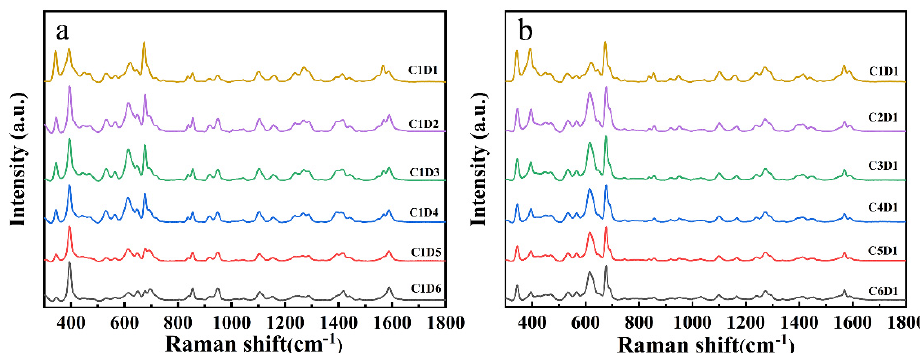
Figure 9. SERS spectra of apple surface samples treated with mixed pesticide of different volume ratio ( a ) CPF volume ratio is one ( b ) 2,4-D volume ratio is one (C1D1 means mixed CPF and 2,4-D at a concentration of 1 mg L − 1 in 1:1).